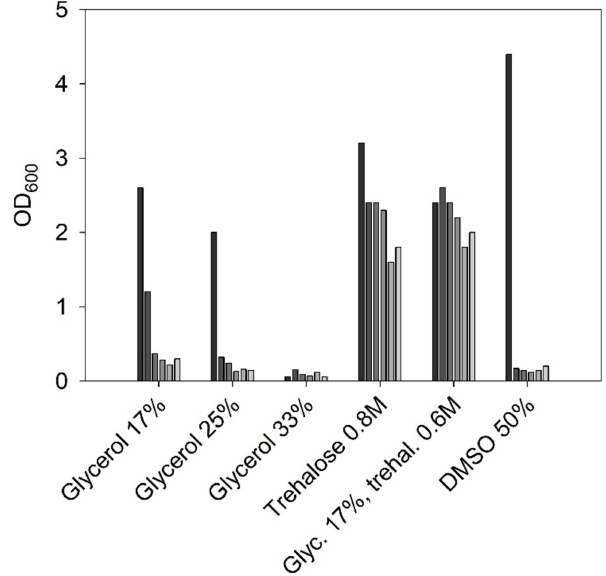
Figure 5. OD 600 values of C. necator cultures inoculated directly with cells from cryoservation stocks. Bars indicate recultivability after 1, 3, 5, 7, 9, 11 months (starting with black bars, descending grey intensities). (1 day of cultivation in TSB at 30 ◦